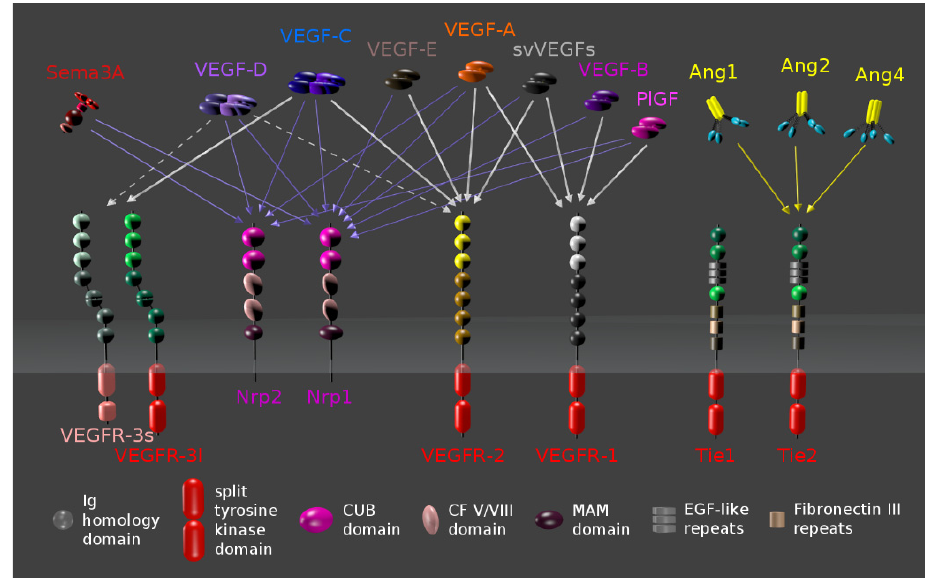
Figure 5. Vascular endothelial growth factor (VEGF) isoforms and their receptors (VEGFR). (Image adapted with permission from: Mjeltsch, CC BY-SA 4.0, https://creativecommons.org/licenses/by- sa/4.0, accessed on 15 May 2022, via Wikimedia Commons.)